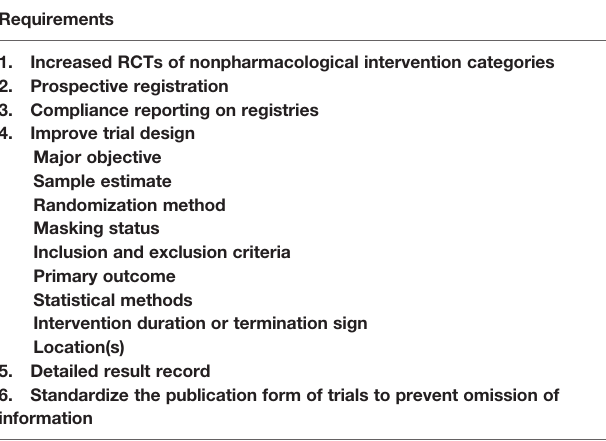
TABLE 3 | Requirements to improve SLE trial quality in mainland